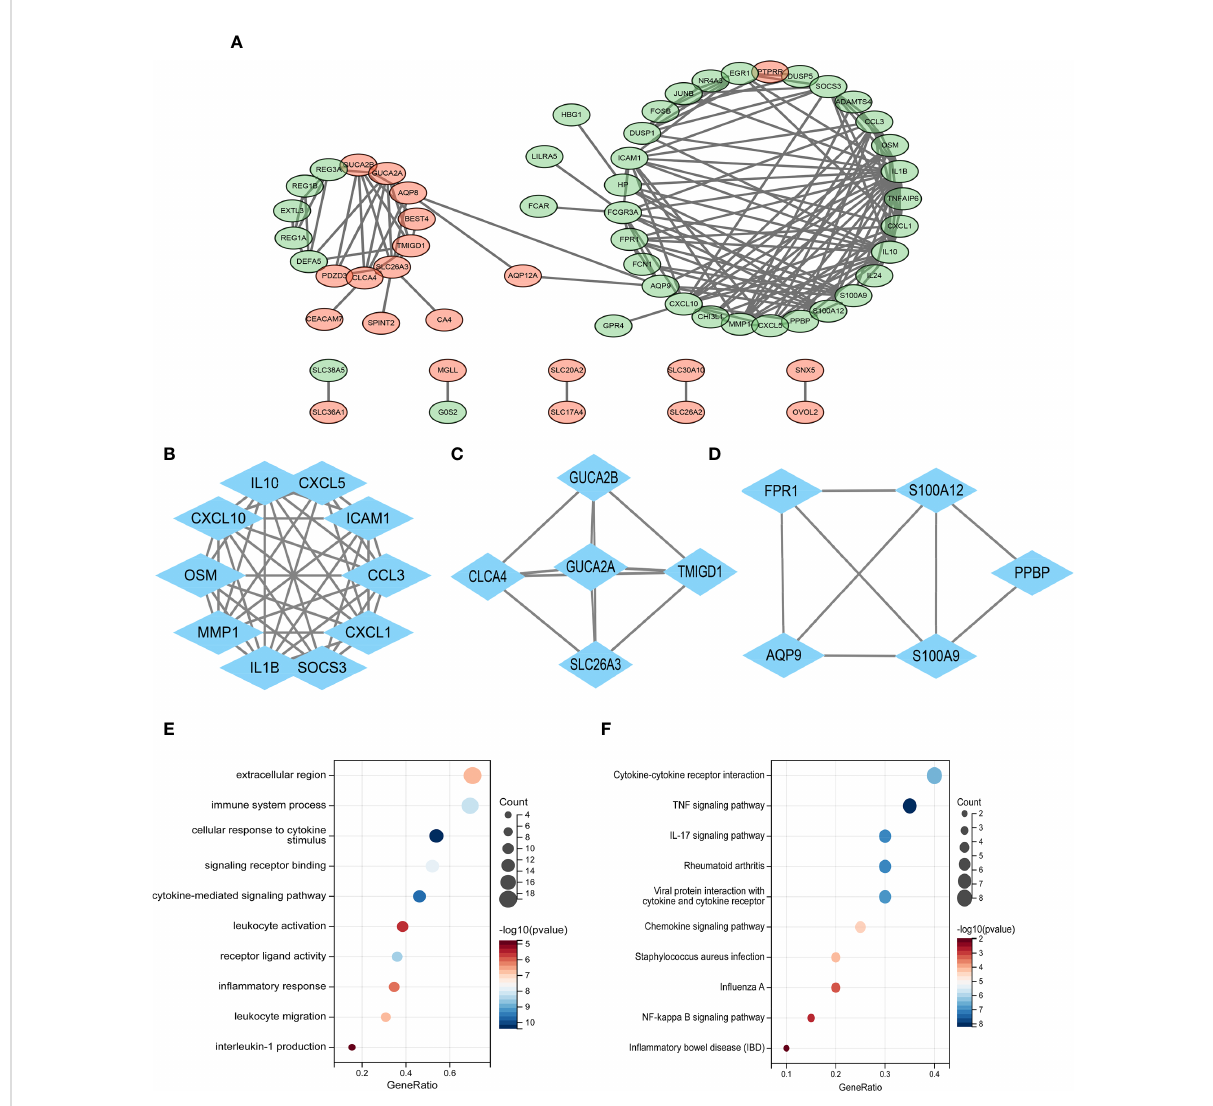
FIGURE 3 (A) PPI network diagram. Green indicates upregulated genes, and red-violet indicates downregulated genes. (B – D) Three signi fi cant gene clustering modules. (E – F) GO and KEGG enrichment analyses of the modular genes. The size of the circle represents the number of genes involved, and the abscissa represents the frequency of the genes involved in the term total genes. PPI, protein – protein interaction; GO, Gene Ontology; KEGG, Kyoto Encyclopedia of Genes and